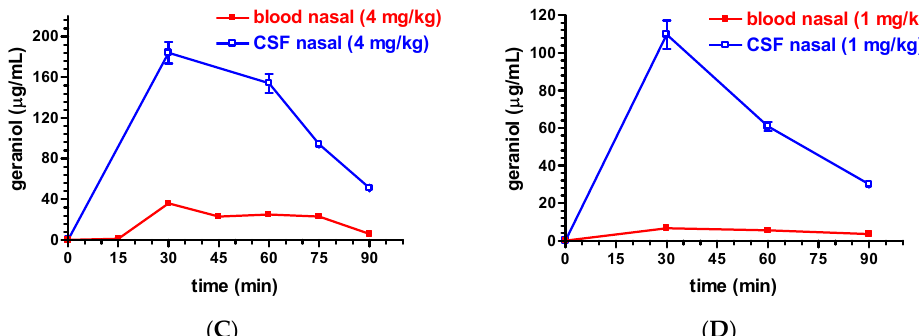
Figure 4. ( A ) Rat blood and cerebrospinal fluid (CSF) geraniol concentrations (µg/mL) within 90 min after oral administration of 50 mg/kg geraniol formulated as G-CS-OA-2.0% emulsion. ( B ) Rat blood and CSF geraniol concentrations (µg/mL) within 90 min after oral administration of 1 mg/kg geraniol formulated as G-CS-OA-2.0% emulsion. ( C ) Rat blood and CSF geraniol concentrations (µg/mL) within 90 min after nasal administration of 4 mg/kg geraniol formulated as G-CS-OA-2.0% emulsion. ( D ) Rat blood and CSF geraniol concentrations (µg/mL) within 90 min after nasal administration of 1 mg/kg geraniol formulated as G-CS-OA-2.0% emulsion. Data are expressed as the mean ± S.D. of at least four independent experiments.